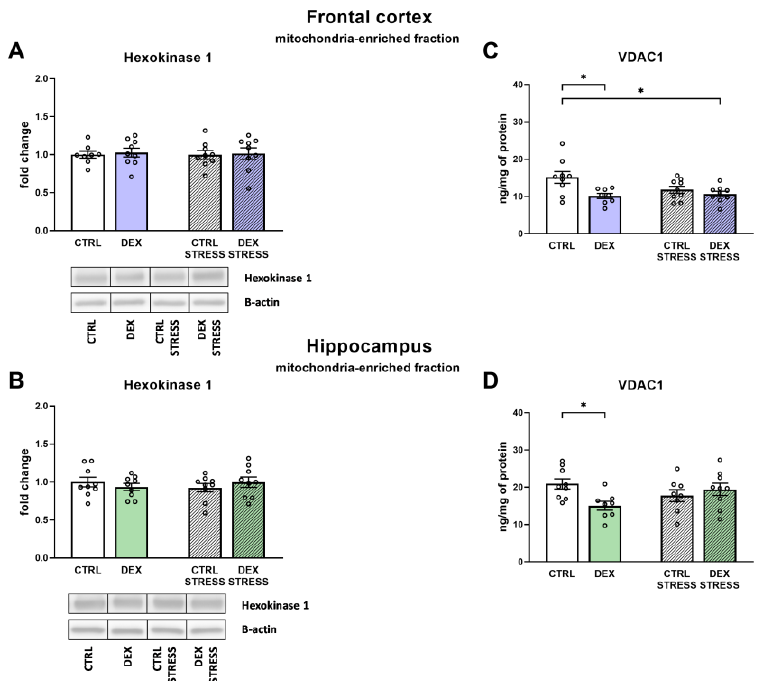
Figure 7. The effects of DEX treatment and acute stress on the levels of hexokinase-1 (HK1) and voltage-dependent anion-selective channel 1 (VDAC1) in the mitochondria-enriched fraction of the frontal cortex ( A , C ) and the hippocampus ( B , D ); HK1 level was determined with Western blotting analysis, and VDAC1 with ELISA assay; * p < 0.05, n = 8–9. The results are expressed as the average fold change ± SEM ( A , B ) or as the mean ± SEM ( C , D ). Statistics: two-way ANOVA, followed by the Duncan test.